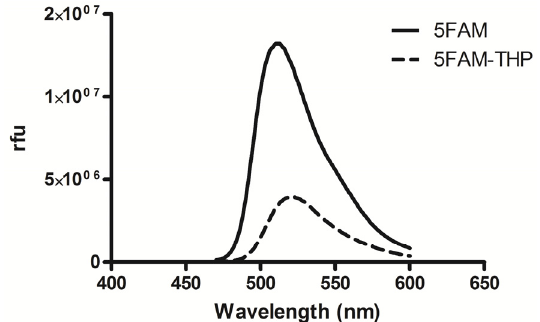
Figure 2. Fluorescence emission spectra of 5FAM (solid) and 5FAM = 480 nm. The decrease in fluorescence signal for 5FAM where λ excitation demonstrates the quenching of fluorescence of the fluorogenic peptide due to close proximity of the 5FAM